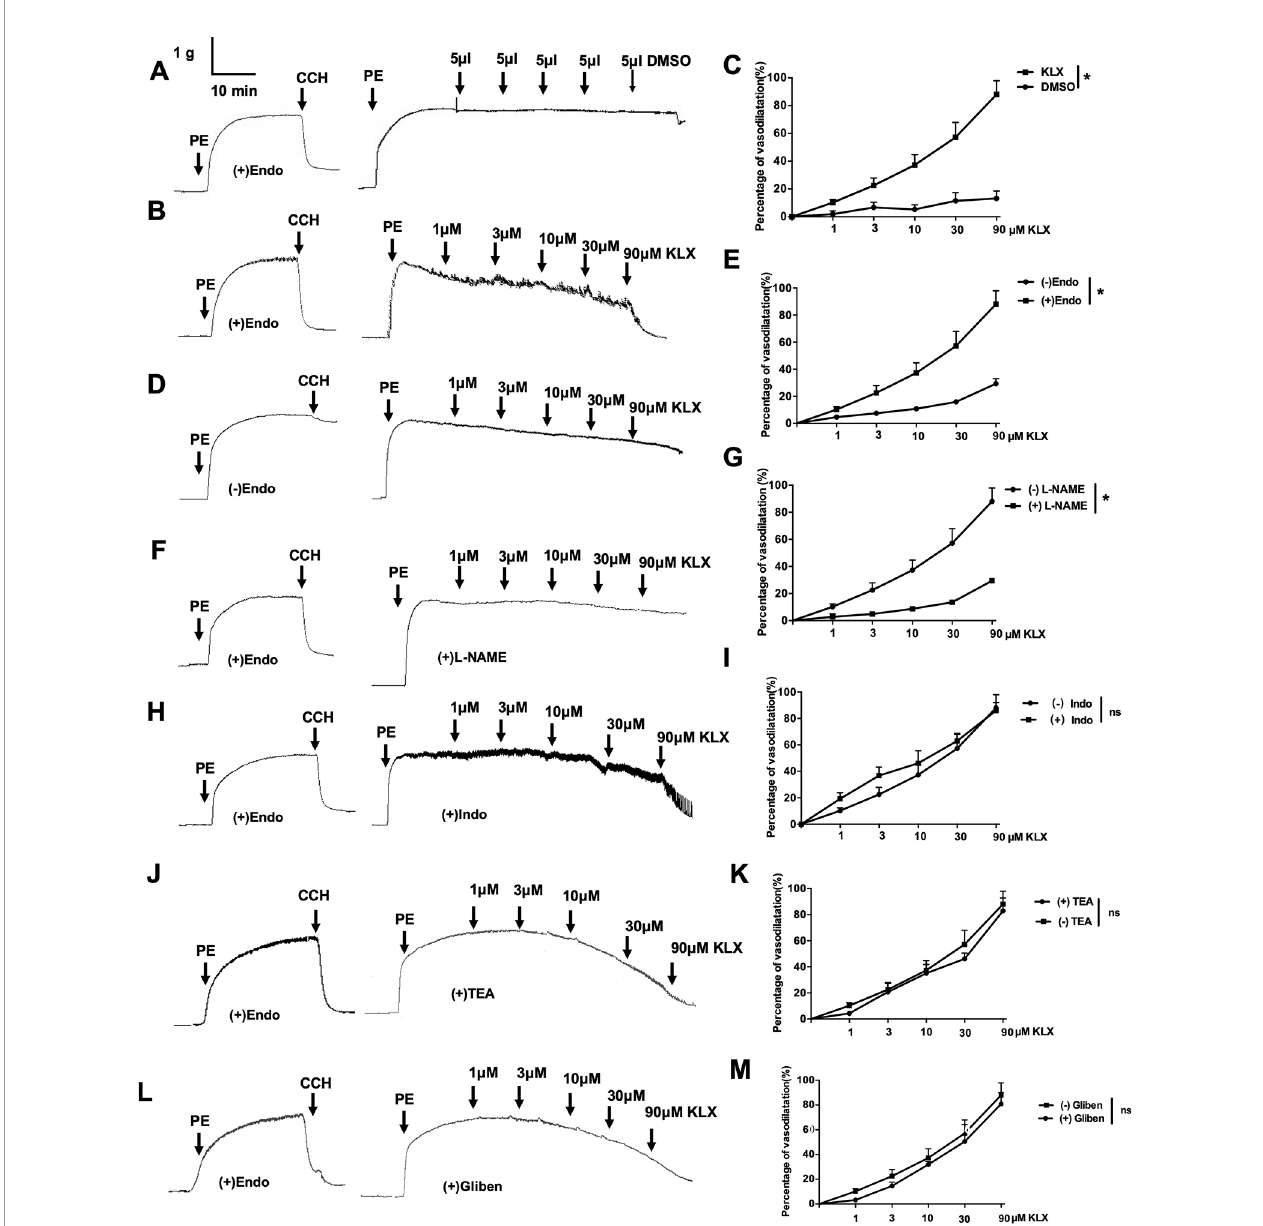
FIGURE 2 | The vascular tension-relieving effects of KLX depend on endothelial integrity and NO generation. (A) Lack of effect of DMSO on the tension of endothelium-intact vascular rings. (B) Relieving effects of varying concentrations (1, 3, 10, 30, and 90 µM) of KLX on the tension of endothelium-intact vascular rings. (C) Dose-response curves of the effects of KLX and DMSO on the tension of endothelium-intact vascular rings. (D) Effect of KLX on the tension of endothelium- denuded vascular rings. (E) Dose-response curves of the effect of KLX on the tension of endothelium-intact and endothelium-denuded vascular rings. (F) Inhibitory effect of L-NAME (eNOS inhibitor) on the vasodilating effect of KLX. (G) Comparison of the effects of KLX on the tension of endothelium-intact vascular rings with or without pretreatment of L-NAME. (H) Effect of indometacin (Indo: COX inhibitor) on the vasodilating effect of KLX. (I) Comparison of the effects of KLX on the tension of endothelium-intact vascular rings with or without pretreatment of indometacin. (J) Effect of TEA (K Ca inhibitor) on the vasodilating effect of KLX. (K) Comparison of the effects of KLX on the tension of endothelium-intact vascular rings with or without pretreatment of TEA. (L) Effect of glibenclamide (Gliben: K ATP inhibitor) on the vasodilating effect of KLX. (M) Comparison of the effects of KLX on the tension of endothelium-intact vascular rings with or without pretreatment of Gliben. Data are presented as mean ± SEM, * p < 0.05; ns, no signi fi cance; n =